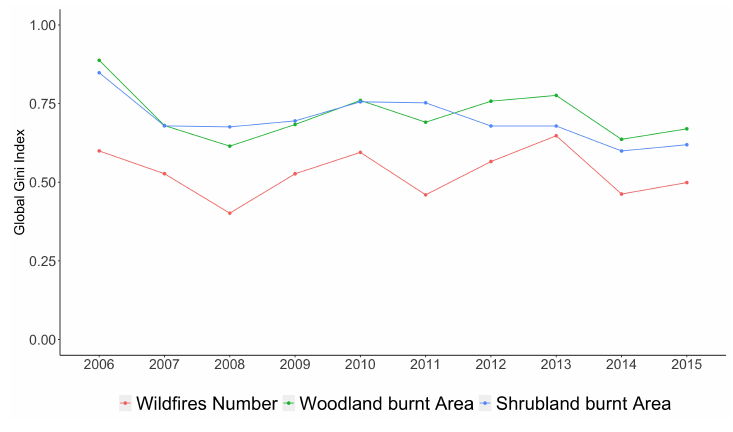
Figure 8. Global temporal Gini index of wildfire